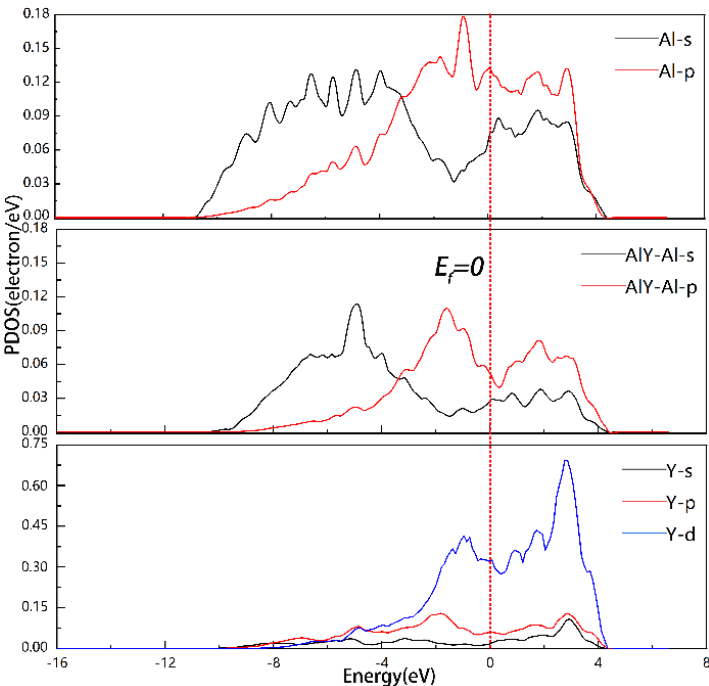
Figure 6. PDOS of Model2 of Al 3 Y(010)|Al(010) interface.